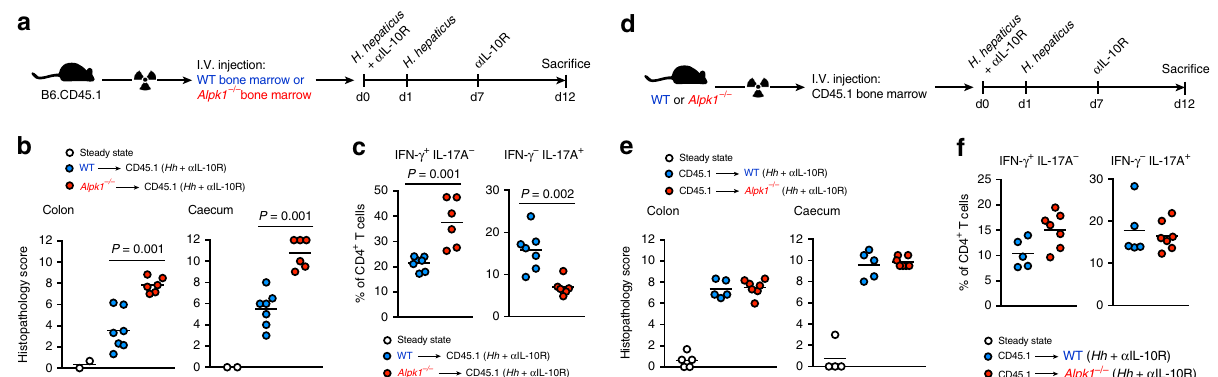
Fig. 4 Control of colitis by Alpk1 depends on its expression in the hematopoietic compartment. a – f Reciprocal bone marrow chimaera experiments in which B6.CD45.1 mice are irradiated and reconstituted with wild type or Alpk1 − / − bone marrow a – c , or wild type and Alpk1 − / − mice are irradiated and reconstituted with wild-type B6.CD45.1 bone marrow d – f . After reconstitution, mice are subjected to Hh + α IL-10R colitis. The Hh -treated groups were compared using Mann – Whitney tests. a – c Colon and caecal histopathology scores ( b ) and frequencies of IFN- γ + IL-17A − and IFN- γ − IL-17A + cells among total colonic CD4 + T cells ( c ). n = 7 recipients of WT bone marrow, n = 6 recipients of Alpk1 − / − bone marrow, and n = 2 steady state. One experiment was performed. d – f Colon and caecal histopathology scores ( e ) and frequencies of IFN- γ + IL-17A − and IFN- γ − IL-17A + cells among total colonic CD4